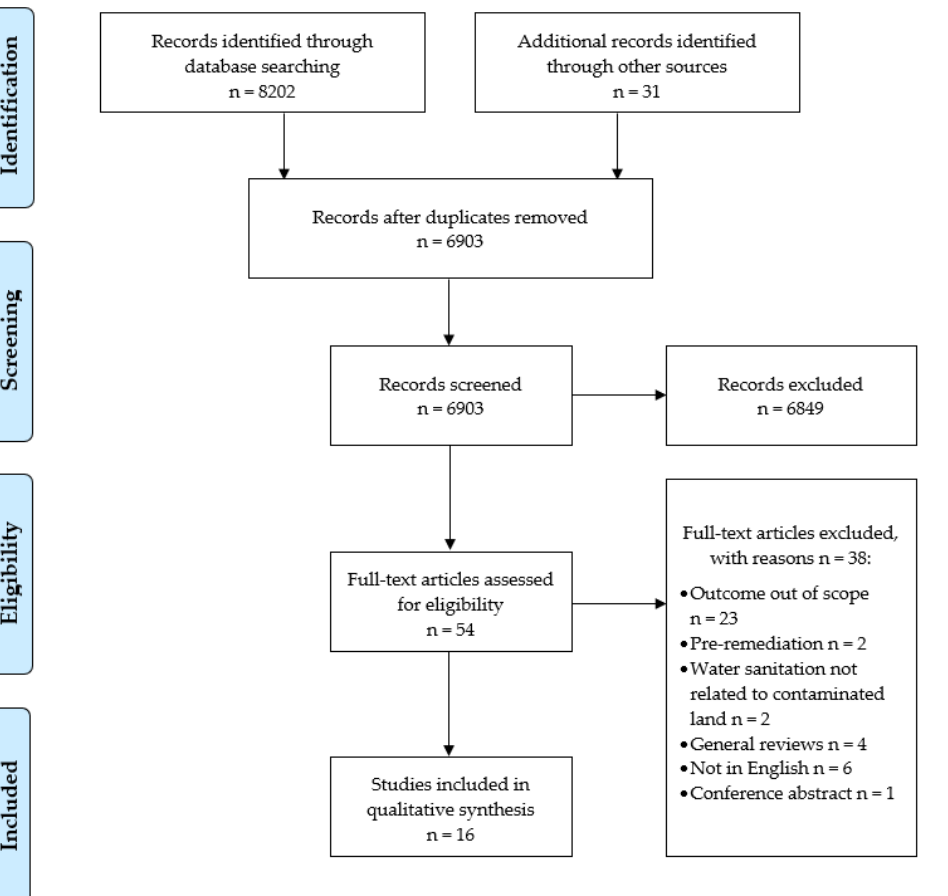
Figure 1. PRISMA flow diagram [25].